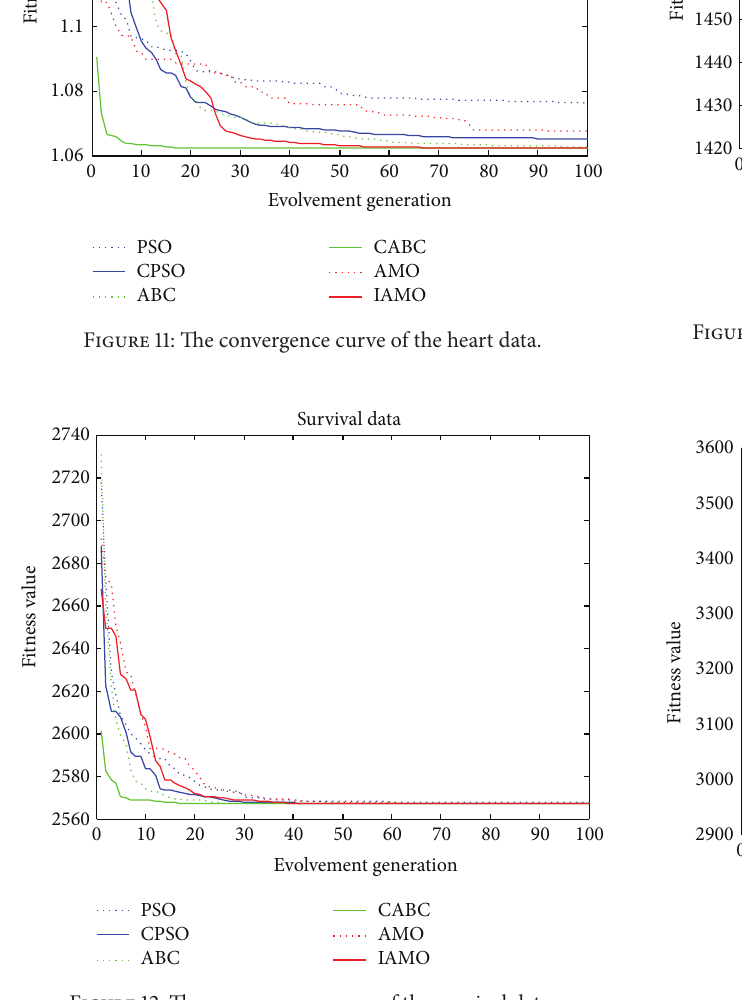
Figure 14: The convergence curve of the cancer